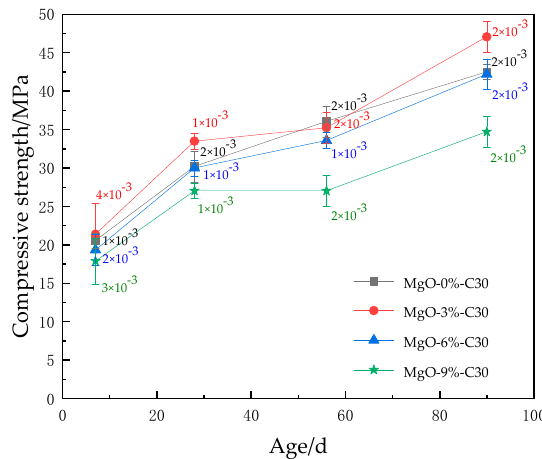
Figure 9. Compressive strength of C30 concrete.